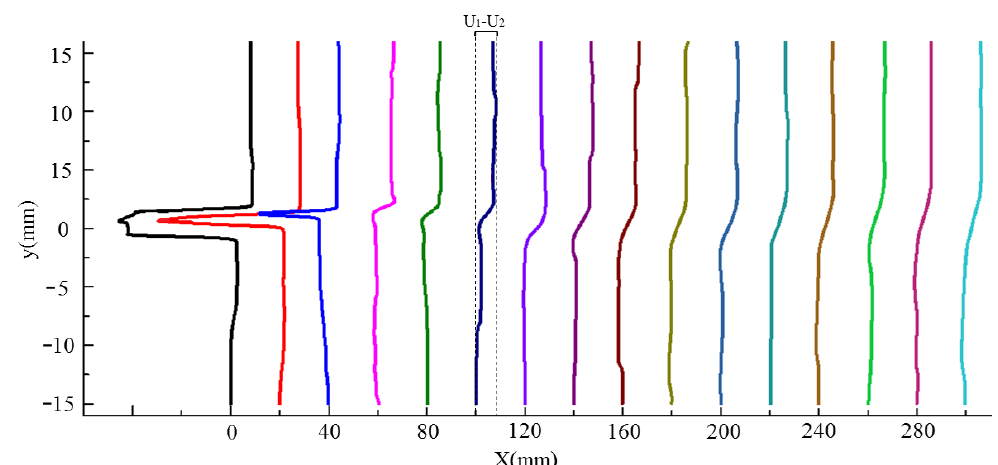
Figure 11. Velocity profiles of simulation in the streamwise direction of case 1.